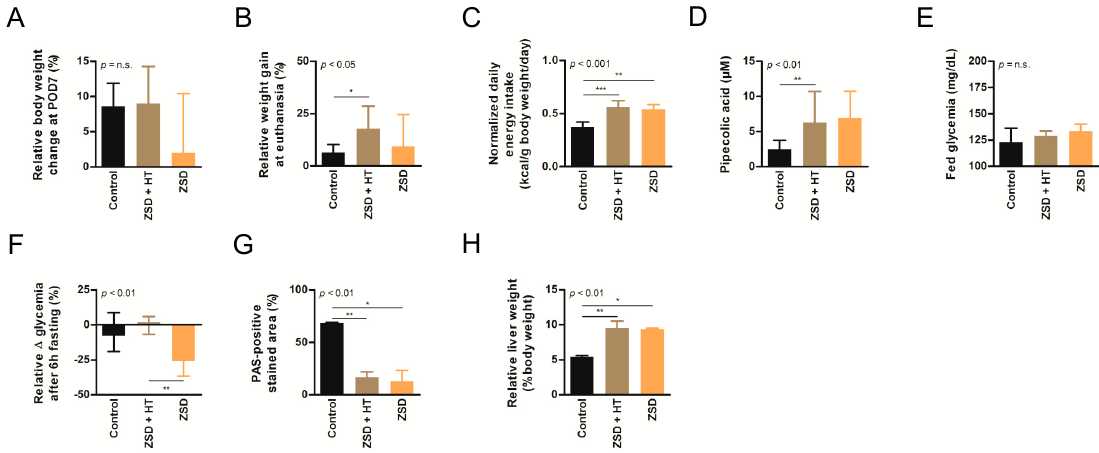
Figure 3. High dose hepatocyte transplantation (HT) was safe but failed to convincedly modify peroxisomal markers in ZSD mice. Relative body weight change at ( A ) post-operative day (POD) 7 or ( B ) sacrifice, ( C ) normalized daily energy intake, ( D ) plasma pipecolic acid levels, ( E ) fed glycemia, ( F ) relative fasting glycemia drop, ( G ) relative liver Periodic-acid Schiff (PAS)-positive stained area (proxy for glycogen content) and ( H ) relative liver weight in control ( n = 6), Zellweger spectrum disorder (ZSD) mice treated with high dose HT ( n = 8) and ZSD mice sham operated ( n = 6). High dose HT protocol confirmed ZSD phenotype in affected mice and corrected fasting glycemia drop in ZSD mice but this was not correlated to increased liver PAS-positive stained area. Kruskal-Wallis test, n (Control – ZSD + HT – ZSD) = 6 – 8 – 6, median ± interquartile range, *: p -value < 0.05, **: p -value < 0.01, ***: p -value < 0.0001, n.s.: not significant.